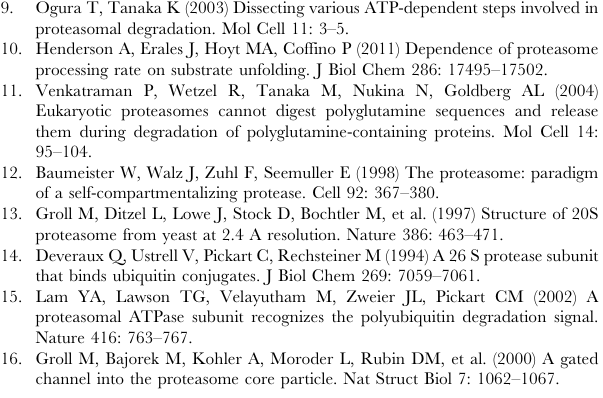
Figure S3 Both apoMb and holo form bind with 20S proteasomes. ApoMb and holoMb were incubated with immobilized 20S proteasome and detected using anti-Mb antibody. Figure S4 F-helix stabilization does not significantly affect the thermal stability or the Trp environment of monitored by secondary structural changes. Ellipticity at 222 nm was used to calculate the fraction folded which is plotted against the incubation temperature. (b) Trp fluorescence of wt apoMb and the F-helix mutant was analyzed under native conditions. Trp environment, an indicator of tertiary fold was similar in the wt and mutant proteins. Figure S5 Identification of proteasome interacting region/s on apoMb by peptide panning. (a) Overlapping, biotinylated peptides (1 m M) corresponding to the primary